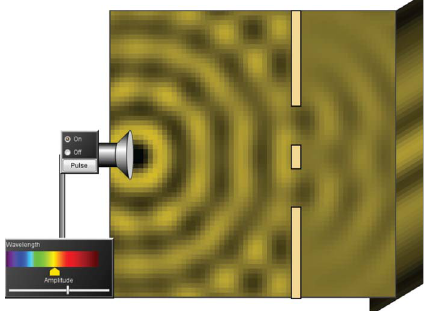
FIG. 3. (cid:1) Color (cid:2) Light wave with 2 slit barrier. Interference pat- tern is shown on the screen to the